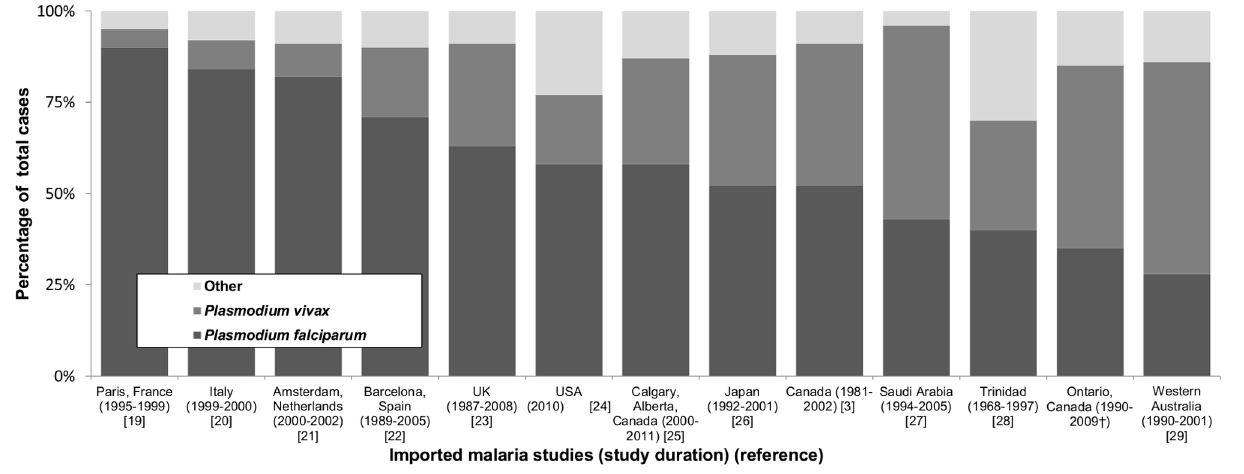
Figure 7. Percentage of imported malaria cases caused by Plasmodium falciparum, Plasmodium vivax , and “Other” (e.g., Plasmodium ovale , Plasmodium malariae , unknown, and unspecified or mixed) according to jurisdiction*. *For period 1990–2009 : P. vivax (51%), P. falciparum (39%), and “Other” (10%). Not shown for 1990–1999 : P. vivax (64%), P. falciparum (28%), and “Other” (10%). Not shown for 2000–2009 : P. vivax (30%), P. falciparum (55%), and “Other” (15%). † This study.